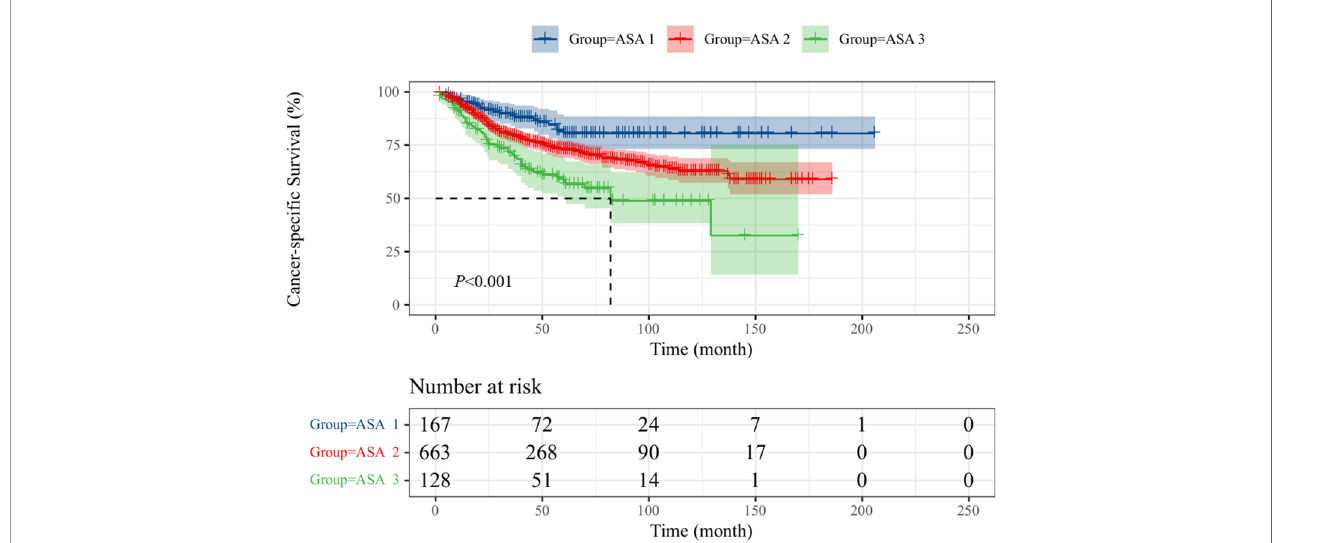
FIGURE 2 | Kaplan-Meier curves for CSS strati fi ed according to ASA